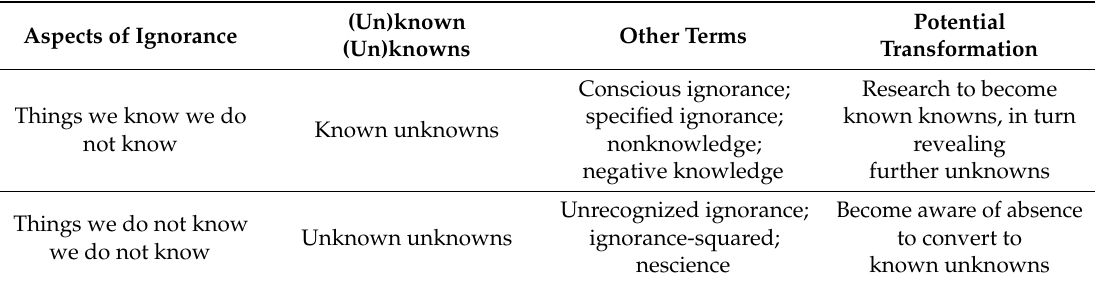
Table 1. Ignorance and its relationships with